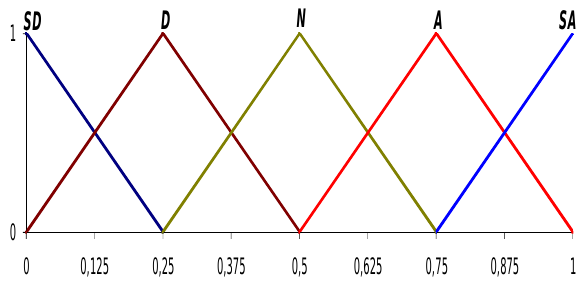
Fig 1. Linguistic terms defined for a five-point Likert